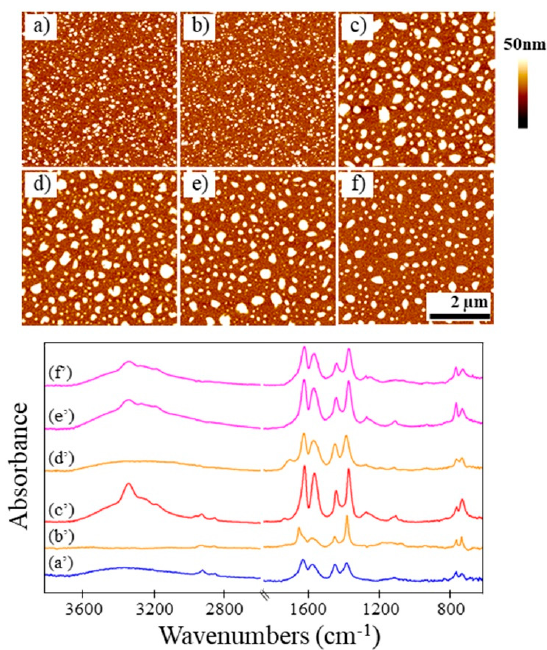
Figure 8. Top: Representative SPM images of HKUST-1 surMOFs ( a ) before exposure to NH 3 ; ( b ) after activation; ( c ) after exposure with prior activation; ( d ) after regeneration; ( e ) after second exposure with activation; and ( f ) after sixth exposure with activation. Bottom: Corresponding IR spectra ( a’ – f’ ).